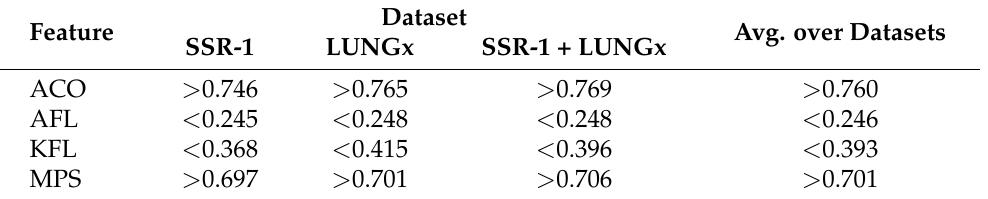
Table 7. Estimated cutoff values for malignancy. The range for all parameters is